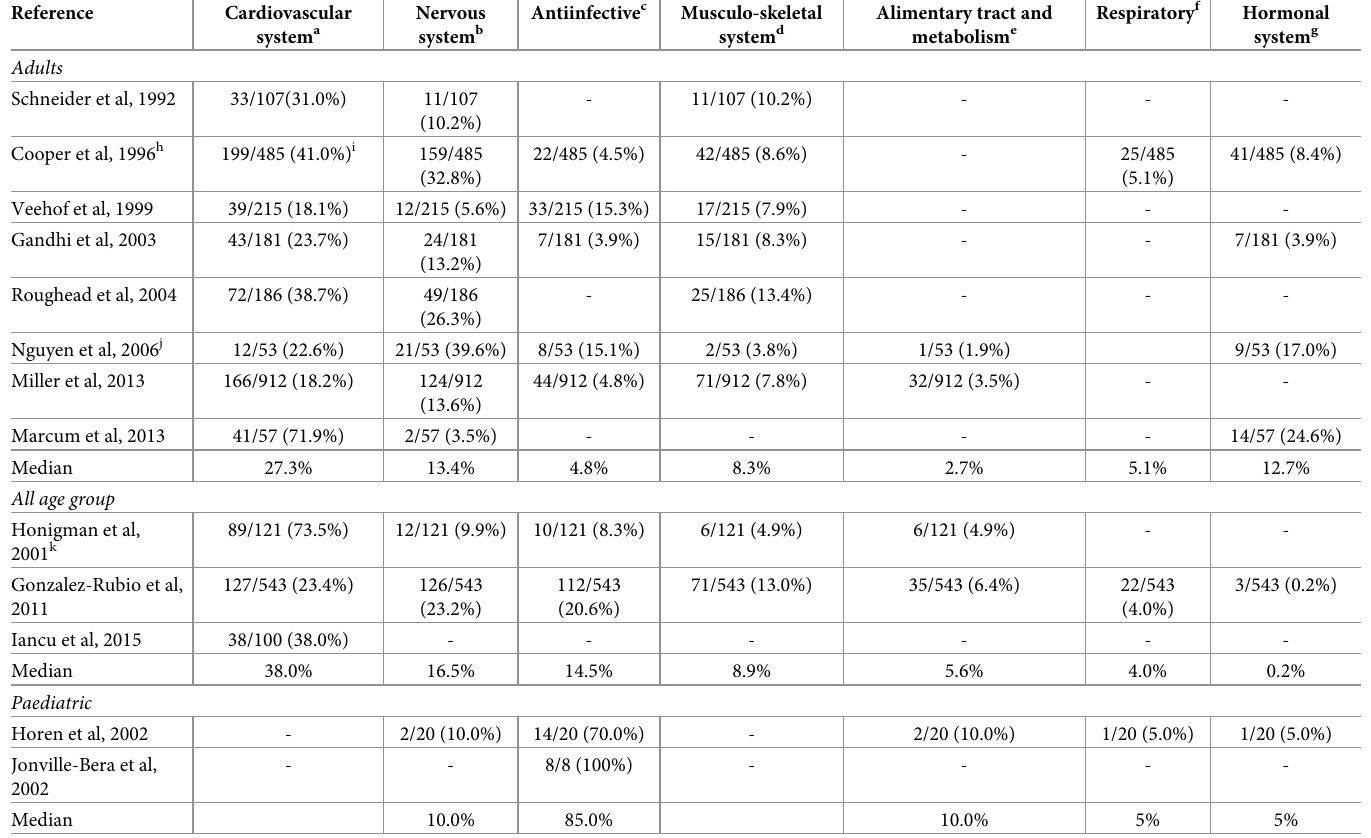
Table 4. The most common drug class implicated in the ADRs in the primary care